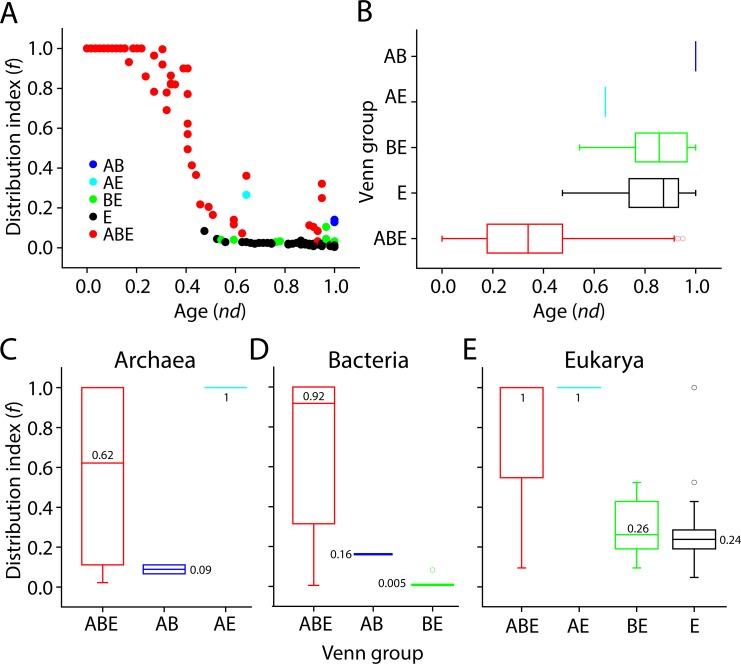
Evolution and distribution of level 2 GO terms.(A) Boxplots exhibit the distribution of level 2 GO terms with respect to evolutionary time and distribution in taxons. (B) Distribution index (f) uncovers evolutionary pattern of level 2 GO terms in taxonomic groups with respect to age (nd). (C) The distribution of level 2 molecular functions in Archaea in the Venn taxonomic groups. (D) The distribution of level 2 molecular functions in Bacteria in the Venn taxonomic groups. (E) The distribution of level 2 molecular functions in Eukarya in the Venn taxonomic groups.